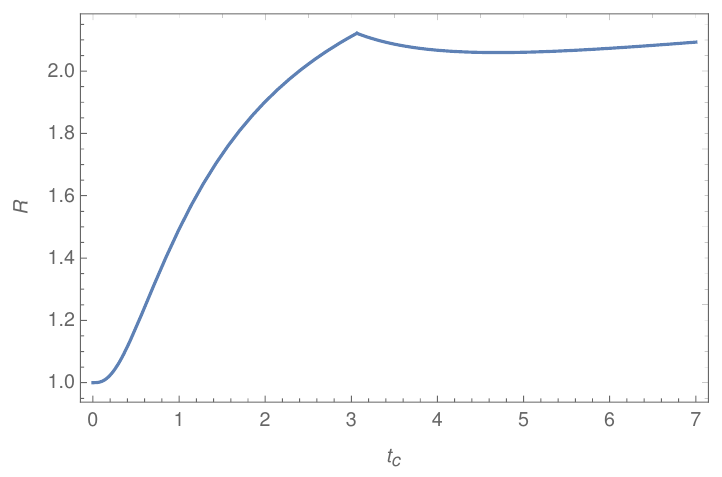
Figure 2 . Recombination factor for the same non-BPS black hole as a function of the critical value t c